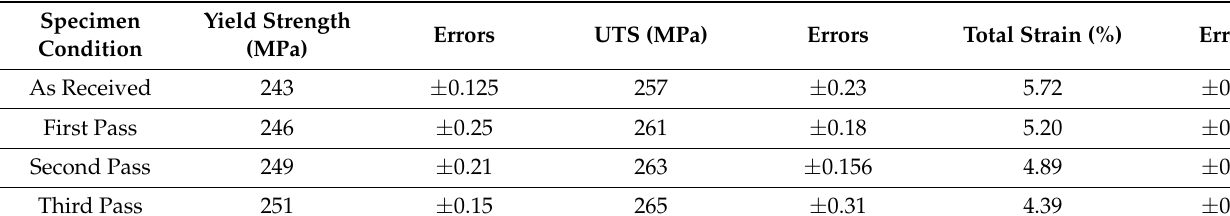
Table 3. High-Temperature Mechanical Properties of Al 5083 at 250 ◦ C.